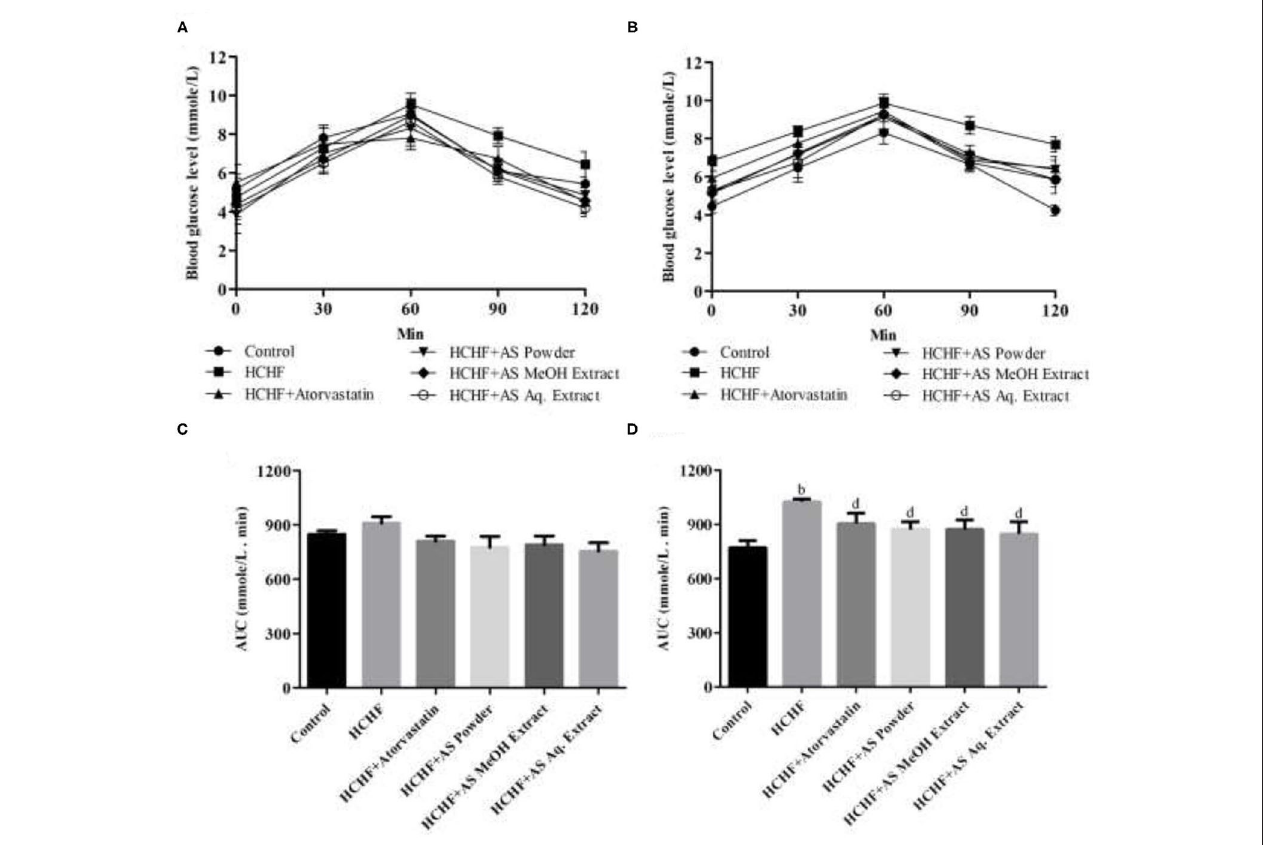
FIGURE 2 | Effect of Amaranthus spinosus on oral glucose tolerance test (OGTT). (A) OGTT at the start of the study, (B) OGTT at the end of the study, (C) OGTT AUC at the start of the study, and (D) OGTT AUC at the end of the study. Values are presented as mean ± SD, where n = 5. b p < 0.005 vs. control; d p < 0.005 vs.